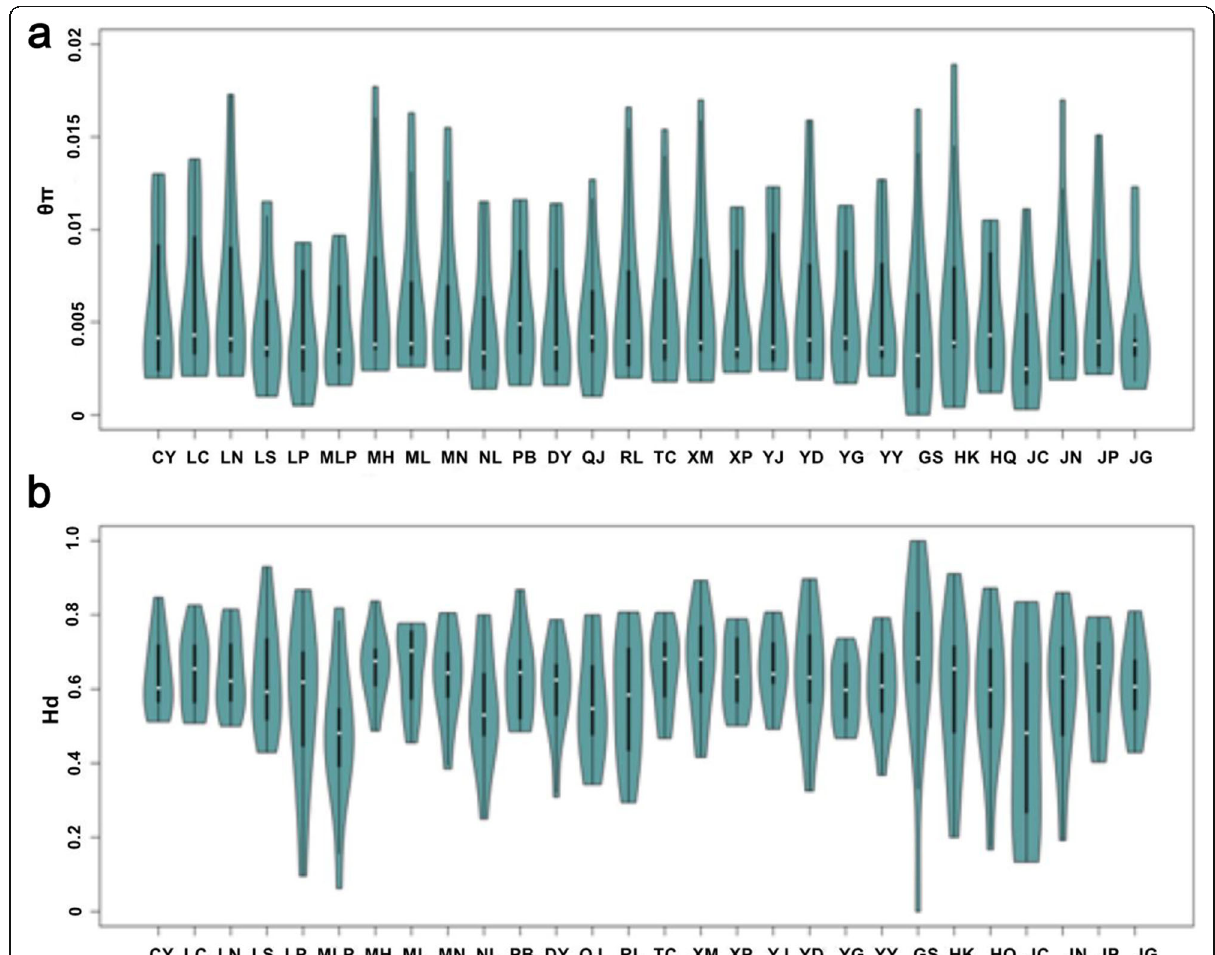
Fig. 1 Violin plot of θ π ( a ) and Hd ( b ) values for rice landraces from 28